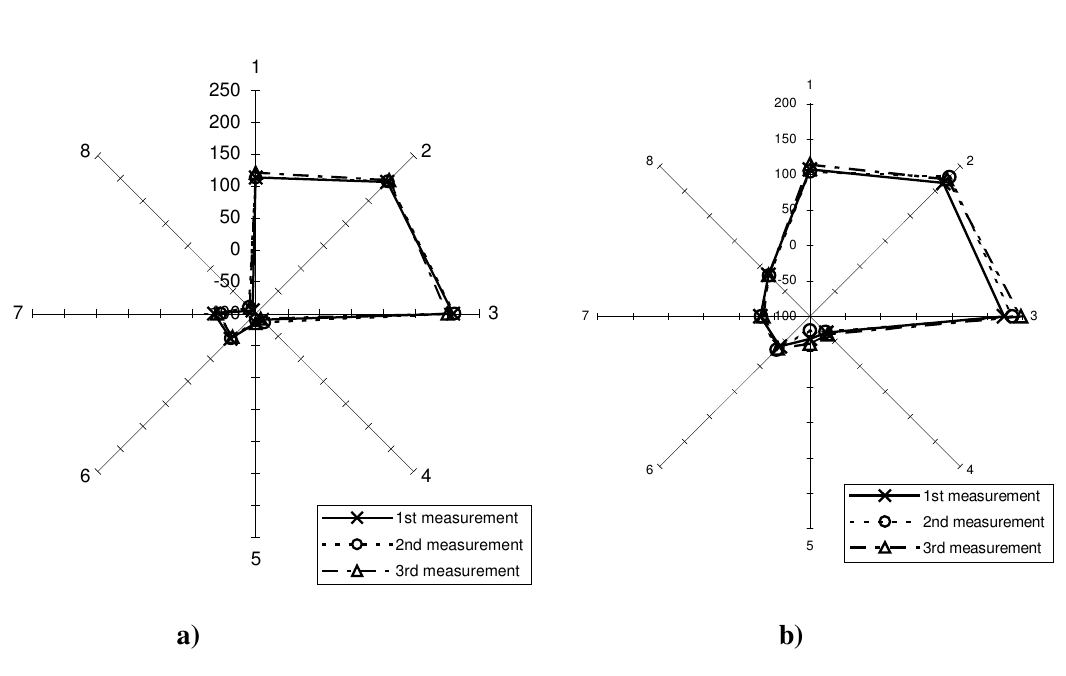
Fig.3. Response pattern of disposable sensor array for three measurements of (a) I Cal Fresh (0 hour) pasteurized milk and (b) I Cal spoiled (48 hours) pasteurized